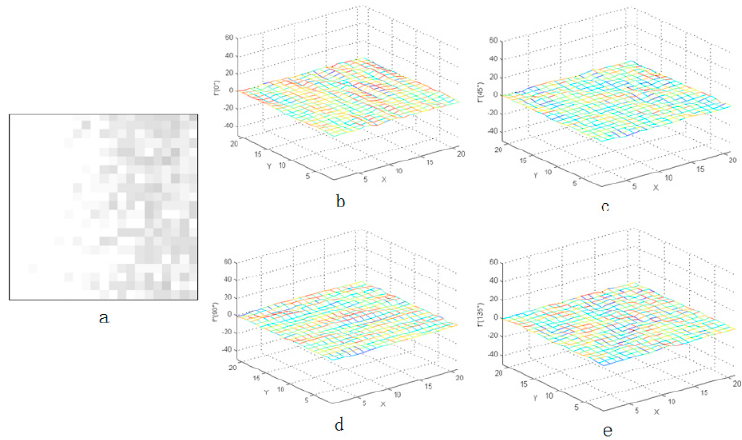
Figure 5. Second-order derivative characteristics of complex background in four directions: ( a ) the complex background and ( b – e ) the three-dimensional distribution of complex background.